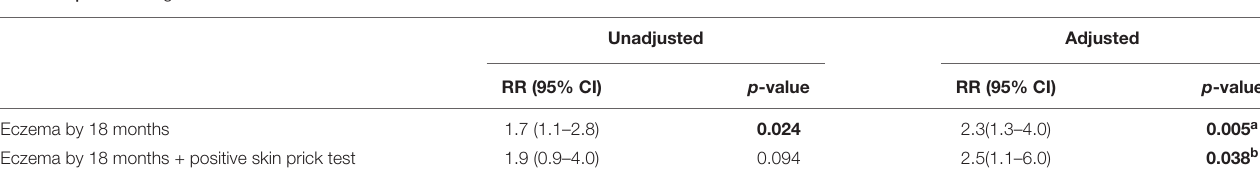
TABLE 4 | Poisson regression between eczema and ADHD at 54 months.